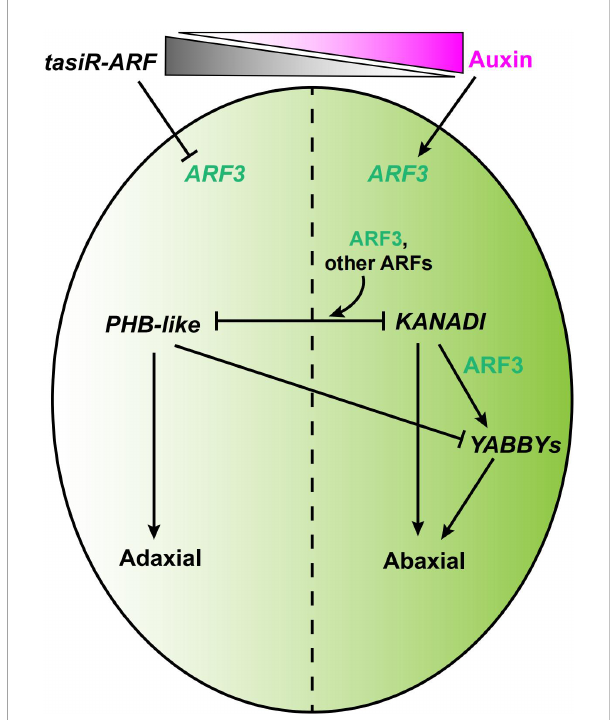
FIGURE 5 A model of the ARF3-mediated regulatory network in the abaxial/ adaxial axis formation of gynoecia. ARF3 is indicated in green, auxin in magenta, and tasiR-ARF3 in gray. Solid arrow indicates positive regulation. Block lines indicate negative